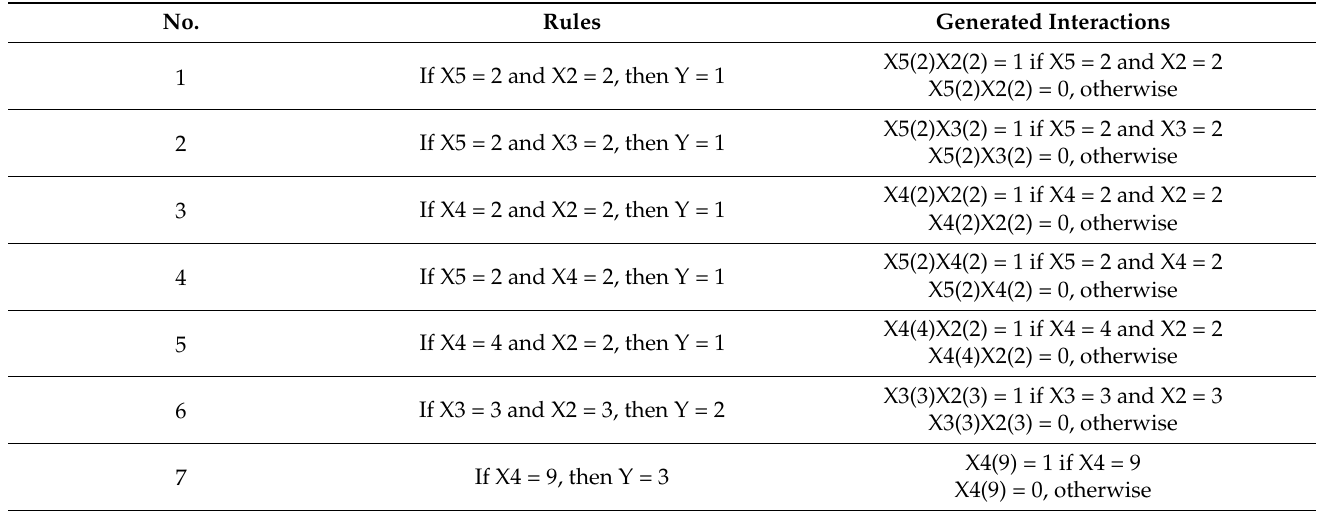
Table 3. Classifier rules generated by CBA: thyroid